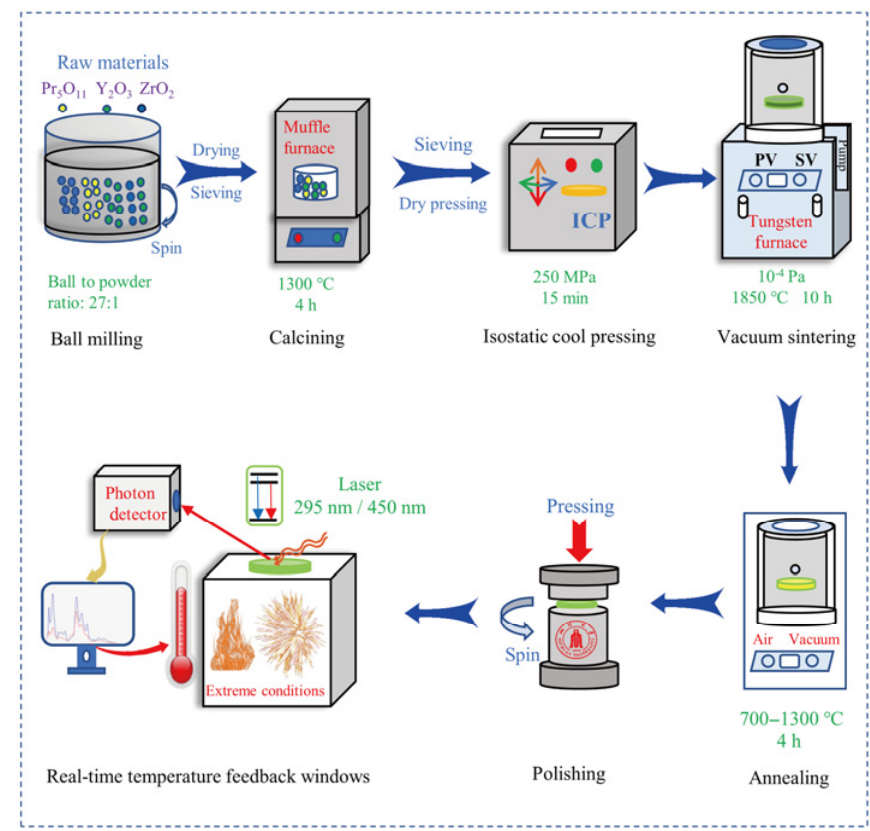
Fig. 1 Schematic flowchart of the preparation of YZO:Pr transparent ceramics. Note: ICP means inductively coupled plasma, and PV and SV represent the present and set values,